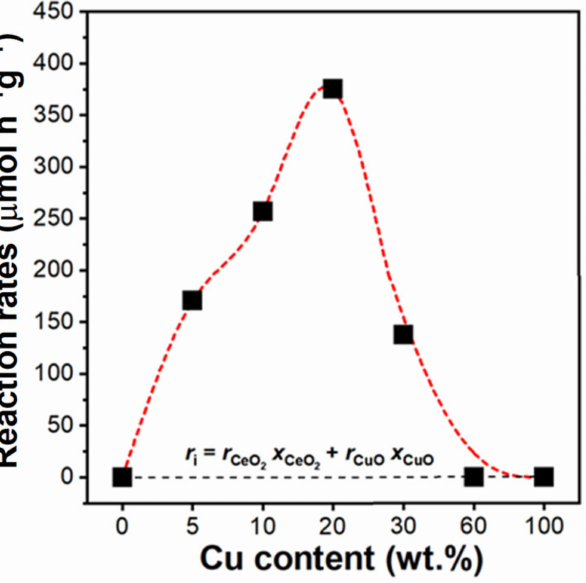
Figure 10. Specific reaction rates of CO oxidation accomplished over the powder catalysts at 50 ◦ C as a function of the Cu